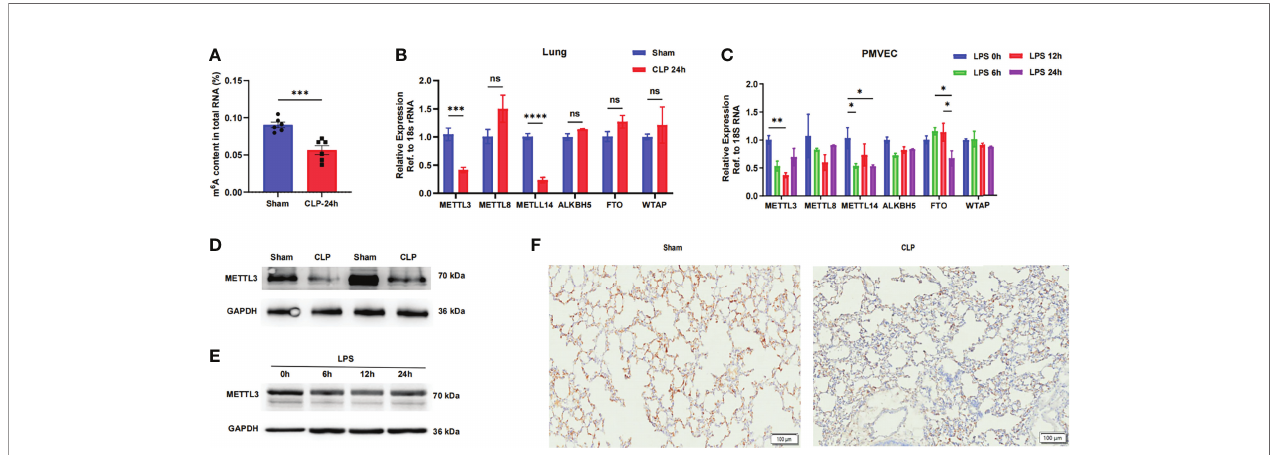
FIGURE 1 | The METTL3-m 6 A pathway is downregulated in sepsis-induced ARDS. (A) ELISA was used to measure mRNA m 6 A levels in sham and CLP-24 h lungs. (B, C) RT-qPCR analysis showing the mRNA expression of m 6 A-related genes in mouse lungs and PMVECs. 18S rRNA was used as the internal control. (D, E) Immunoblot showing METTL3 protein expression in mouse lungs and PMVECs. GAPDH was used as the loading control. (F) Representative images of METTL3 immunostaining in sham lungs and CLP lungs. Scale bars, 100 mm. All data are expressed as the mean ± SD of three independent experiments (n=6). *p < 0.05; **p<0.01; ***p < 0.001; ****p < 0.0001; ns, no signi fi